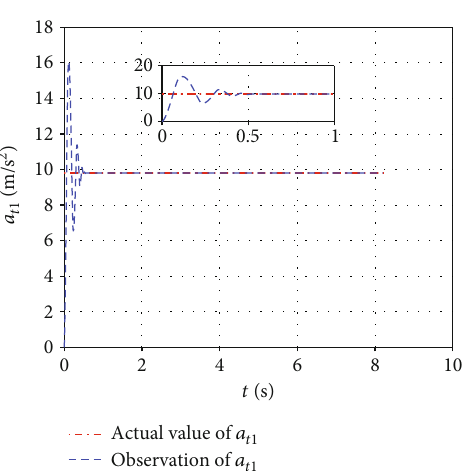
Figure 19: Target acceleration estimation in the pitch plane.